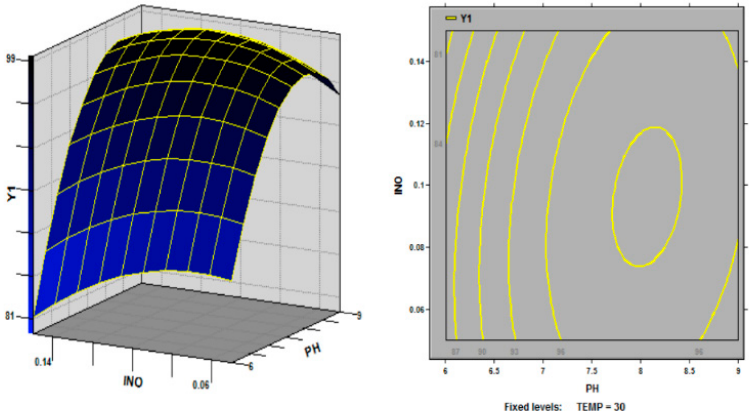
Figure 1. Three-dimensional response of the effects of pH ( X 1 ) and inoculum volume ( X 3 ) on the degradation ( Y ) of beta-cypermethrin by BCC01.